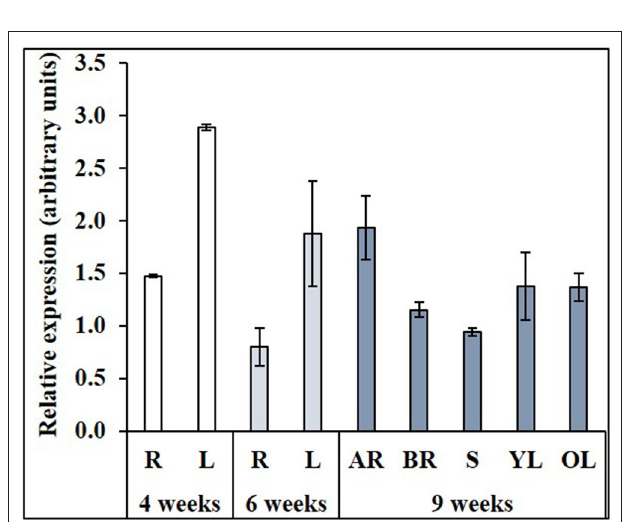
FIGURE 5 | Expression of NtNRAMP3 during development. WT tobacco plants were grown at the control conditions ( ¼ Knop’s medium) for up to 9 weeks. At three selected developmental stages NtNRAMP3 transcript level was monitored by RT-qPCR and normalized to the NtPP2A expression level. Expression of NtNRAMP3 was determined in (i) roots (R) and leaves (L) of 4-week-old plants; (ii) roots (R) and leaves (L) of 6-week-old plants; (iii) apical (AR) and basal fragments of roots, stem (S), young (YL) and old (OL) leaves of 9-week-old plants. Values correspond to mean ± SD ( n ≥ 3); those with a ratio greater than 2 are considered significantly different ( Jain et al.,